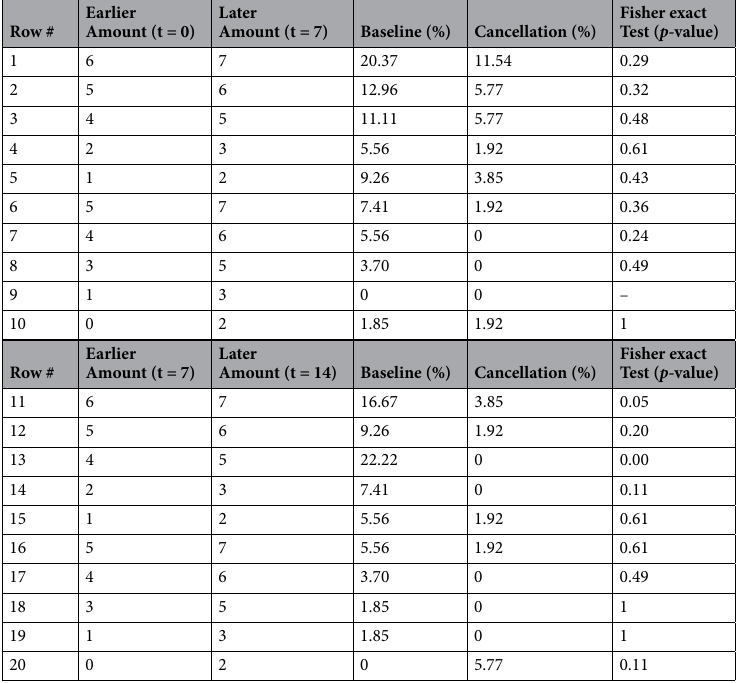
Table 3. Stimuli and results from Experiment 3 (losses). Percentages indicate the percent of participants choosing the larger later